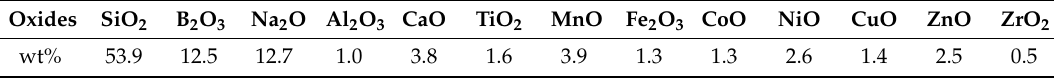
Table 2. Enamel frit composition obtained by ICP-AES analysis.